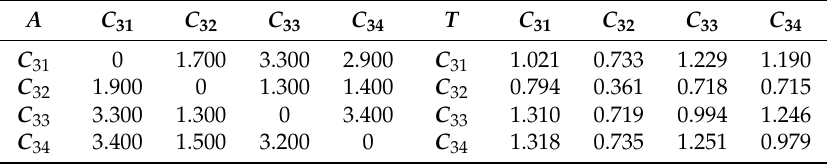
Table 4. The Average-direct influence relation matrix and total influence relation matrix of criteria in D 3 .